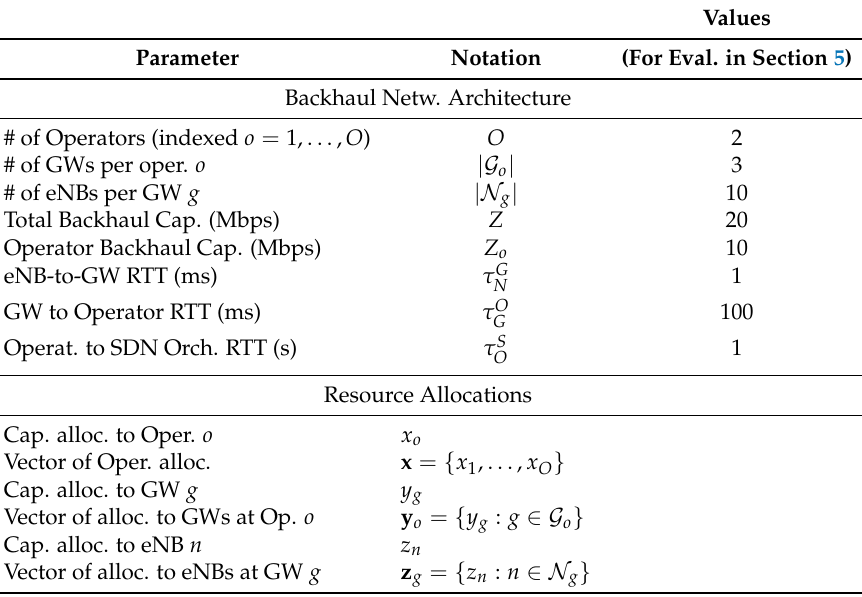
Table 1. Summary of model